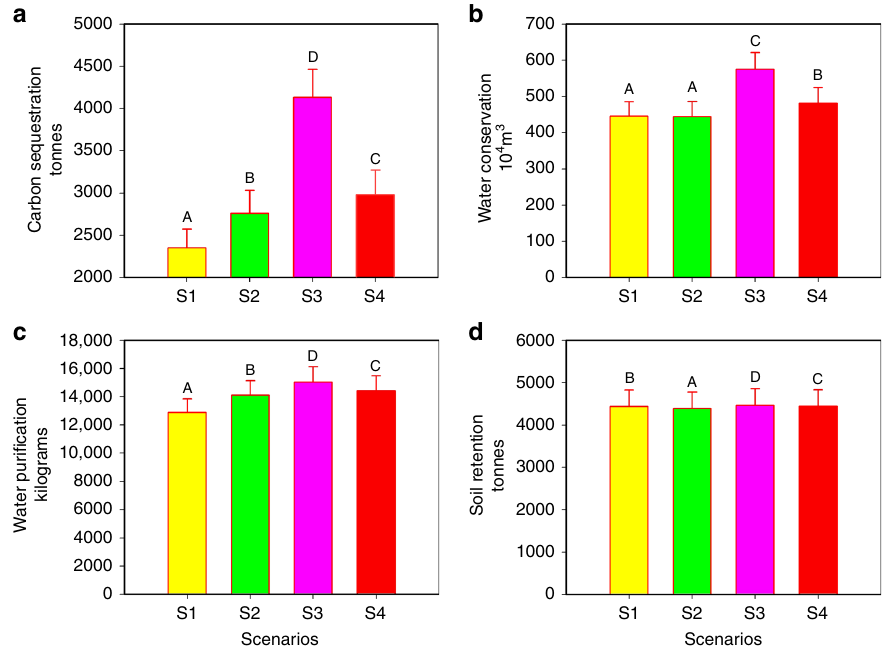
Fig. 6 Ecosystem service values for each scenario. a The estimated average annual carbon sequestration service in tonnes of carbon stored for each scenario. b The estimated average annual water conservation service in 10 4 m 3 of water stored for each scenario. c The estimated average annual water puri fi cation service in kilograms of nitrogen stored for each scenario. d The estimated average annual soil retention service in tonnes of soil retained for each scenario. For each ecosystem service, we estimate the annual production at the subdistrict level ( N = 236 subdistricts) to determine the average annual amount; data show mean ± standard errors of each service calculated. The different colors in each graph represent the different scenarios where S1 is yellow, S2 is green, S3 is magenta, and S4 is red to illustrate the tradeoffs among land use plans on the suite of ecosystem services. The different uppercase letters denote signi fi cant differences among scenarios at P < 0.01 in a paired samples t